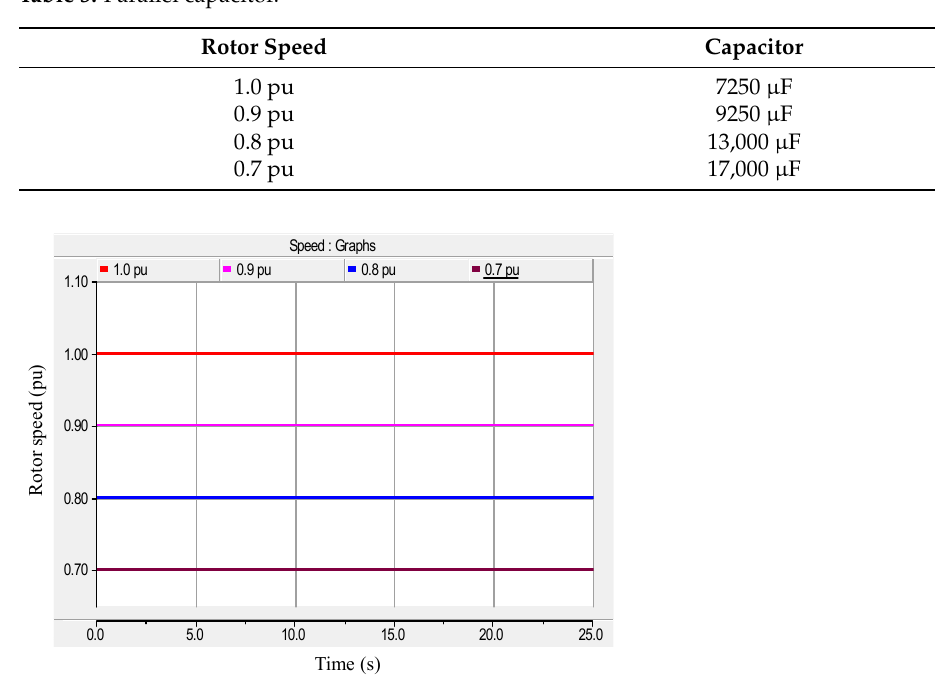
Figure 16. Rotor speed variation. Table 3. Parallel capacitor.